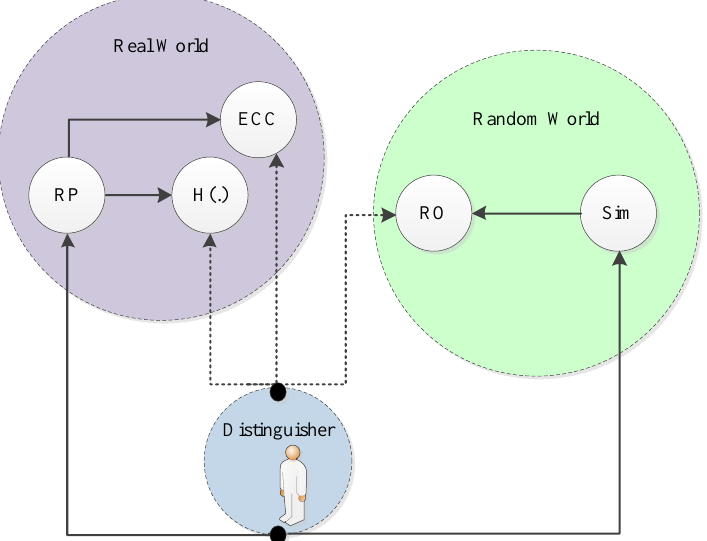
Figure 6. Real or Random (RoR) model; RP: Real Protocol, Sim: Simulator; RO: Random